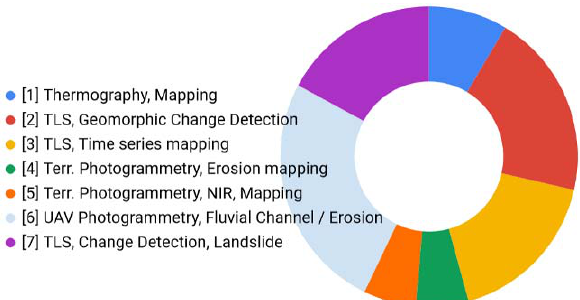
Figure15. Assignments with first choice by